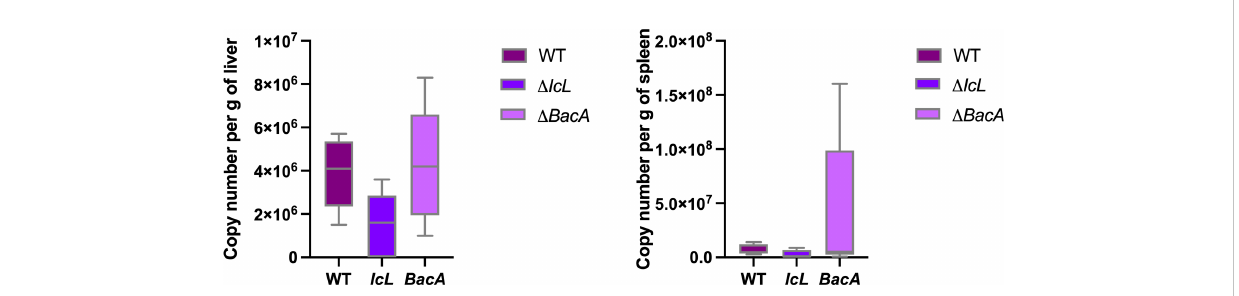
FIGURE 3 MAP quanti fi cation in mice (n=14/group) liver and spleen, three weeks after intraperitoneal infection with 5×10 8 CFU of MAP strains. F57 qPCR was employed to quantify genomic equivalents (GE) of MAP in 1 gram of tissue. The difference among groups were assessed by one-way ANOVA and then further validated by Tukey-Kramer